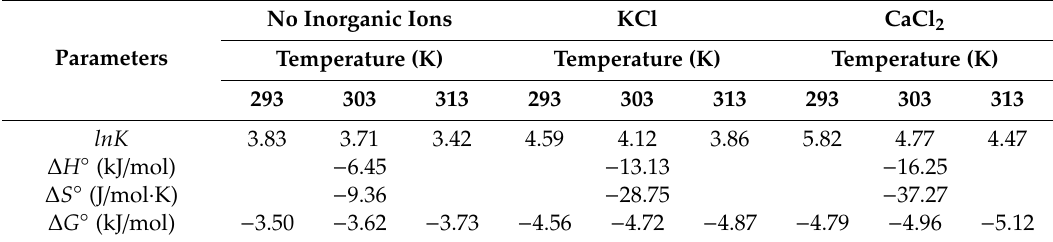
Table 5. Thermodynamic parameters for the adsorption of quinoline onto coke powder. No Inorganic Ions KCl CaCl 2 Parameters Temperature (K) Temperature (K) Temperature (K) 293